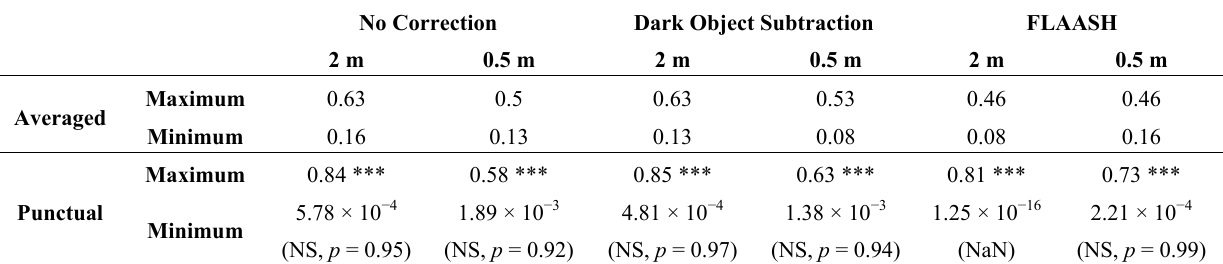
Table 3. Pearson product-moment correlation coefficients ( r ) of the best and worst averaged and performance of the bathymetry retrievals against spatial resolution and atmospheric correction. No Correction Dark Object Subtraction FLAASH 2 m 0.5 m 2 m 0.5 m 2 m 0.5 m Maximum 0.63 0.5 0.63 0.53 0.46 Averaged